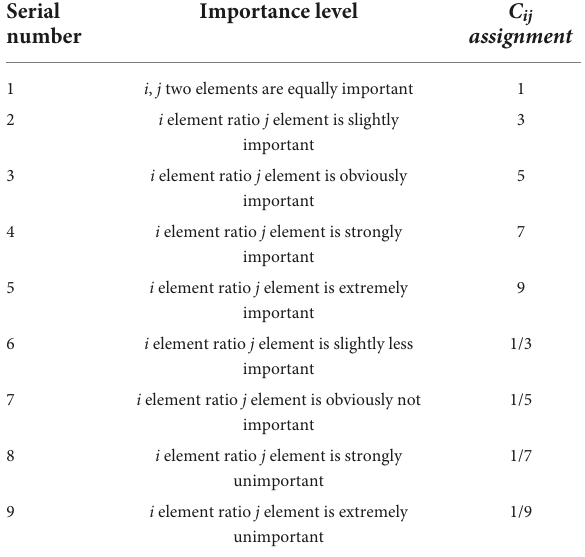
TABLE 3 Judgment matrix scale.